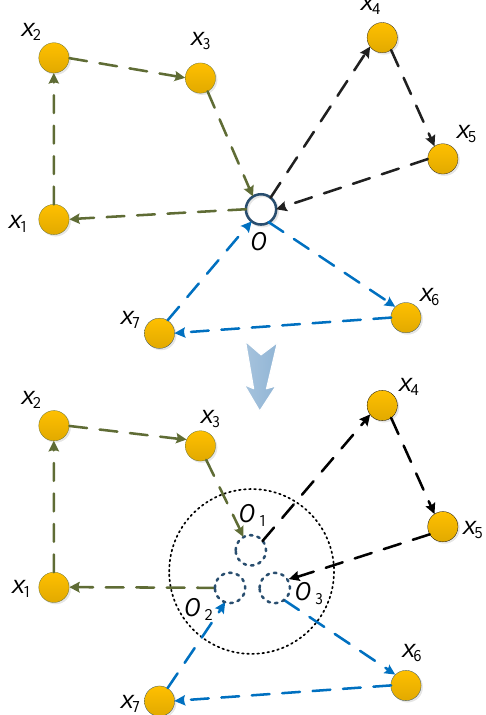
Figure 2. Convert the multipath problem into a single path